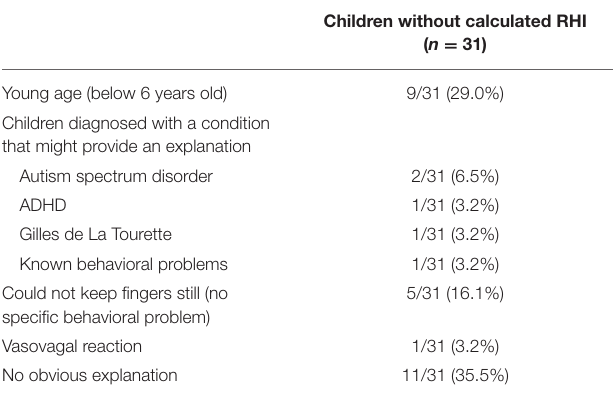
TABLE 1 | Overview of probable explanations of failed RHI